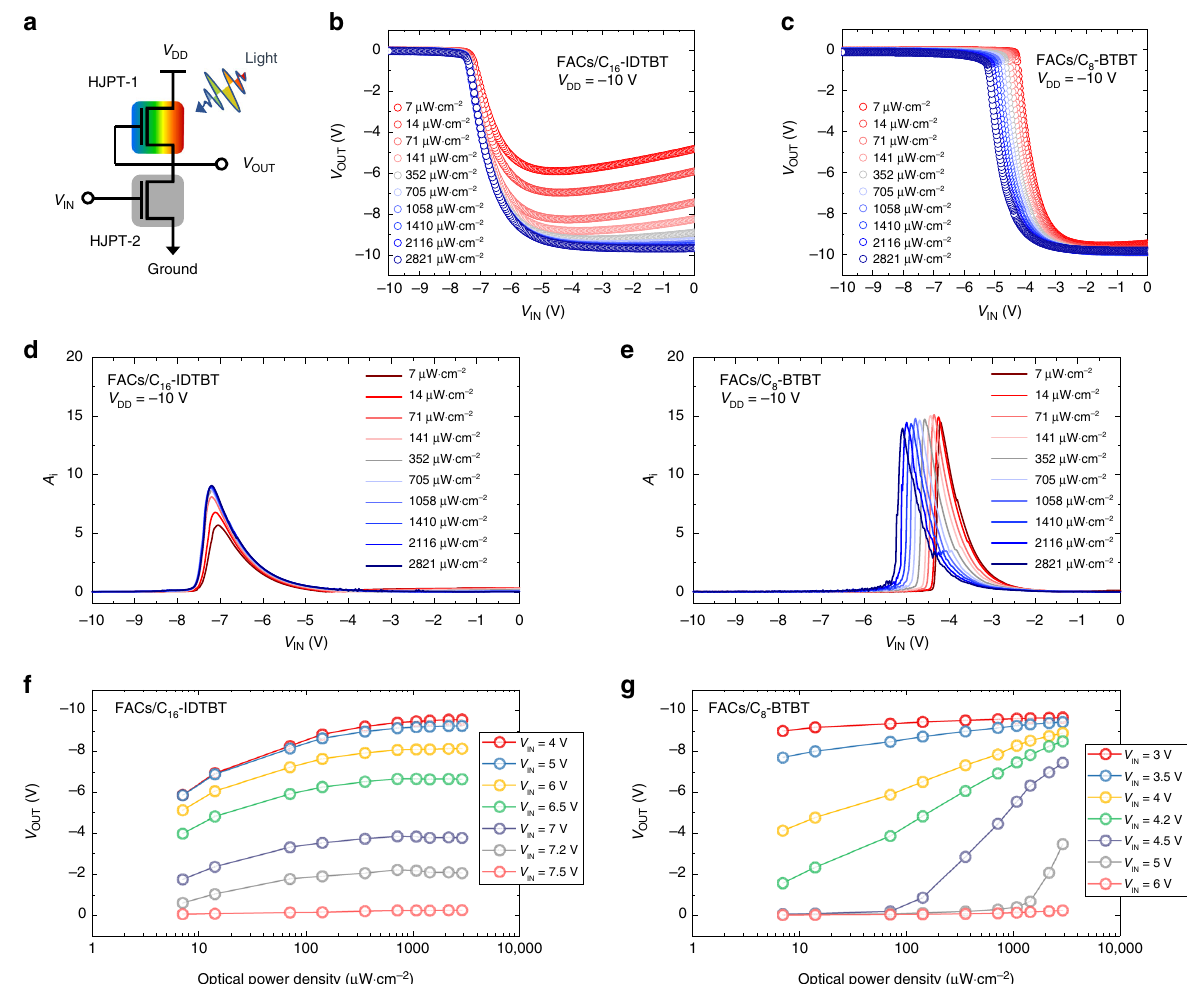
Fig. 6 Transfer characteristics for HJPT photo-inverters. a Schematic of a PMOS-like HJPT photo-inverter to resemble a common-source ampli fi er for assessing the phototransistor performance metric. V DD , V IN and V OUT stand for supply voltage, input voltage signal and output voltage signal, respectively. b , c , Transfer characteristics ( V OUT vs. V IN ) measured using a 475-nm LED light source under different incident light intensities for photo-inverters composed of HJPTs using b FACs/C 16 -IDTBT and c FACs/C 8 -BTBT. d , e Corresponding intrinsic ampli fi cation (A i ) obtained for d FACs/C 16 -IDTBT and e FACs/C 8 -BTBT. f , g Effect of incident optical power density on V OUT measured at a fi xed voltage supply V DD of − 10 V for different V IN biases for the f FACs/C 16 -IDTBT photo-inverter and g FACs/C 8 -BTBT